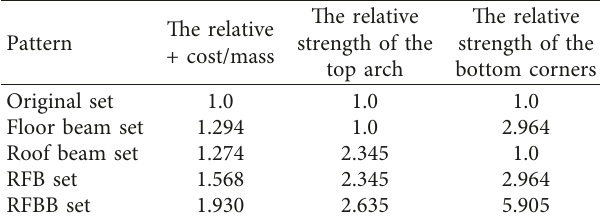
Table 2: Strength and cost comparisons between original set and new